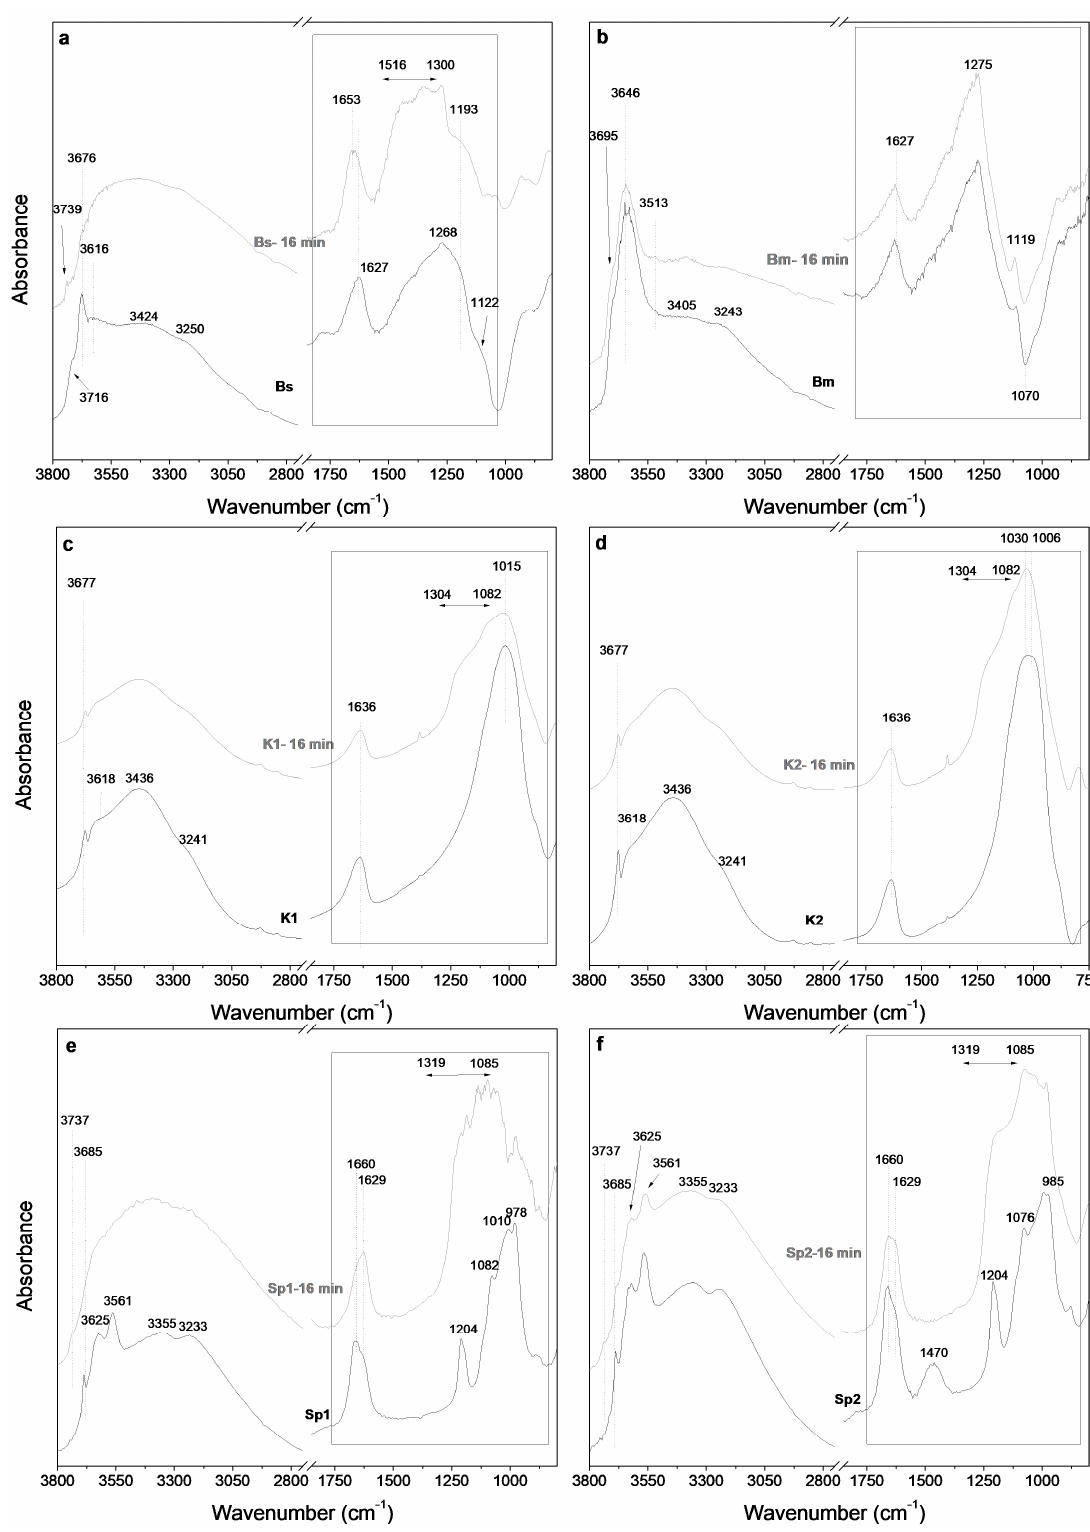
Figure 4. Comparison of the FTIR spectra of saponite Bs ( a ), montmorillonite Bm ( b ), kerolite K1 ( c ), kerolite K2 ( d ), sepiolite Sp1 ( e ) and sepiolite Sp2 ( f ) and the material obtained after 16 min of MAT.